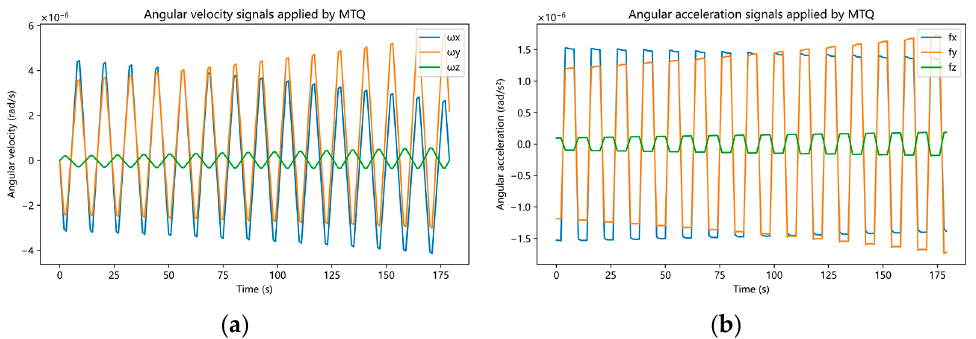
Figure 6. Angular velocity and angular acceleration signals applied by MTQ during the first CM- Cal maneuver: ( a ) angular velocity; ( b ) angular acceleration.